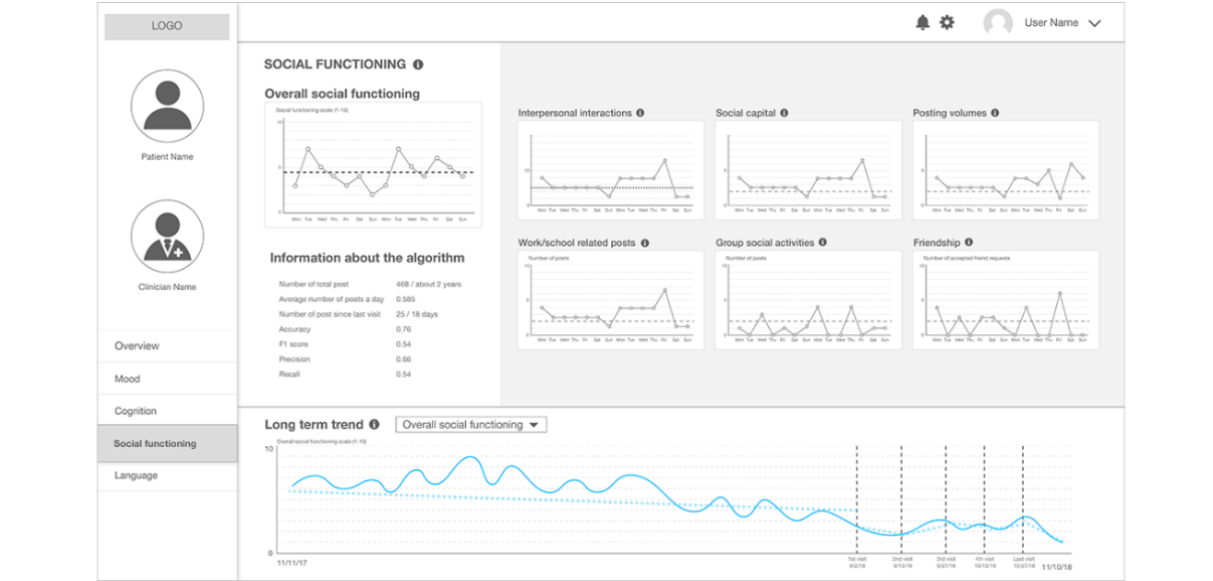
Figure 5. The second prototype: a clinical state and trend visualization interface – "Social Functioning".